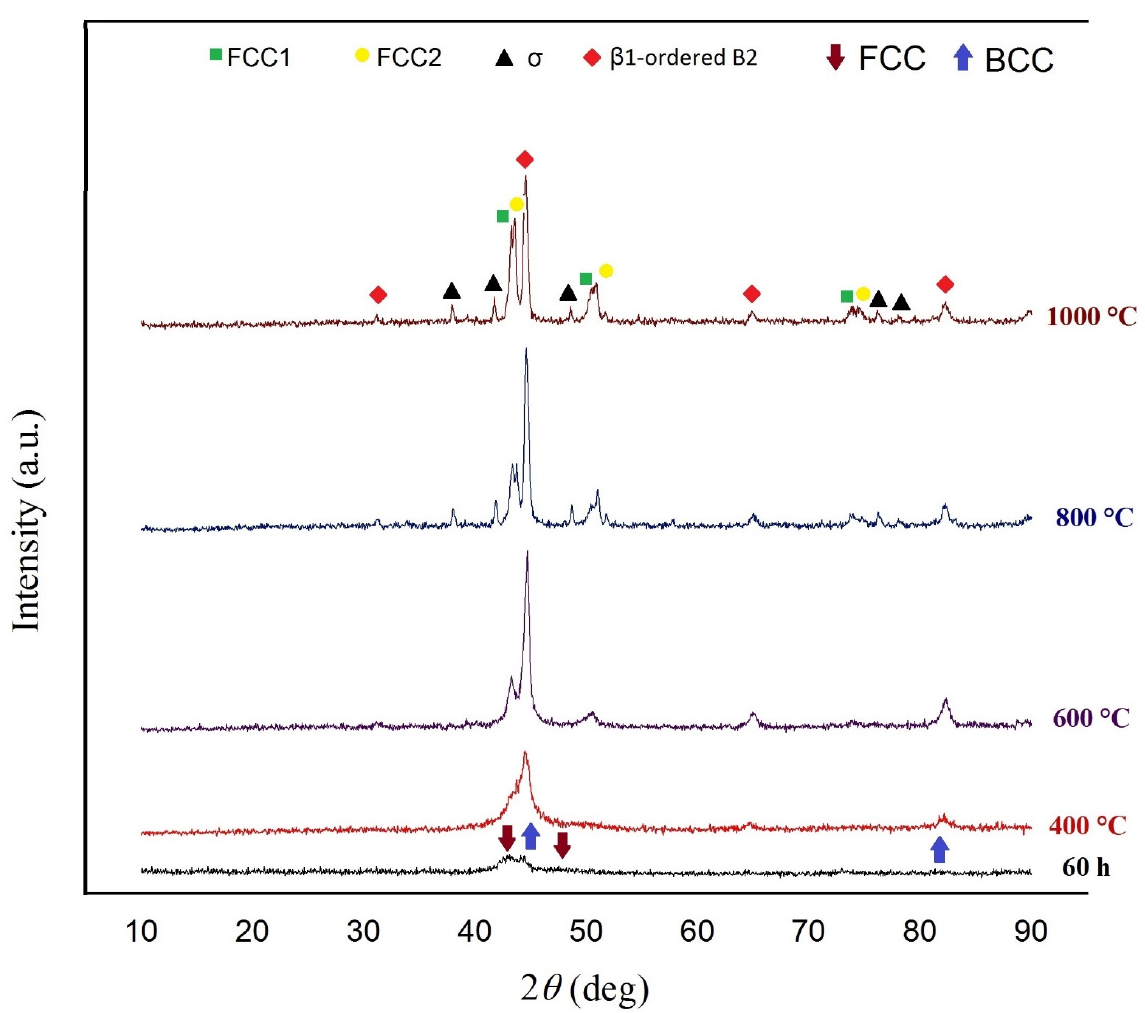
Figure 9. XRD patterns of annealed AlCrCuFeNi HEA powders at different temperatures.